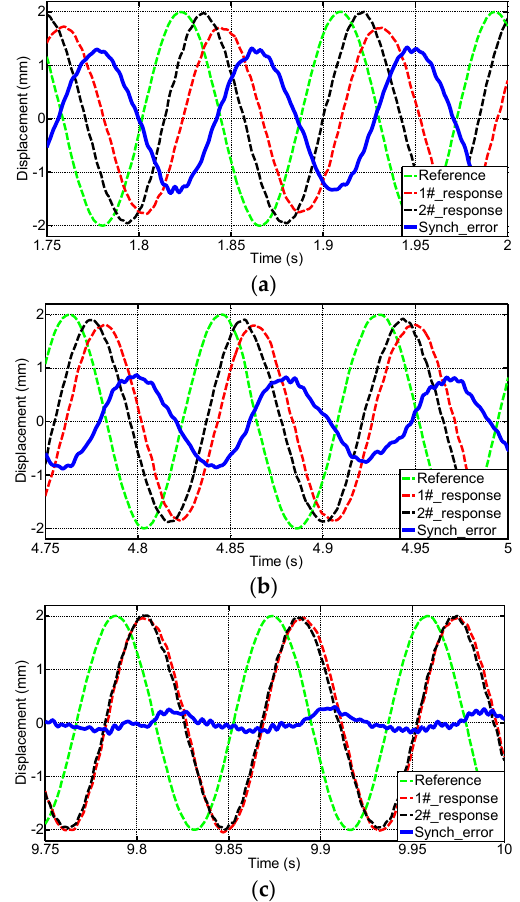
Figure 18. Sine signal synchronization control test results. ( a ) Without synchronization control; ( b ) synchronization control with standard sliding mode control (SMC); ( c ) Proposed sliding mode control based on adaptive reaching law (ASMC) synchronization control.